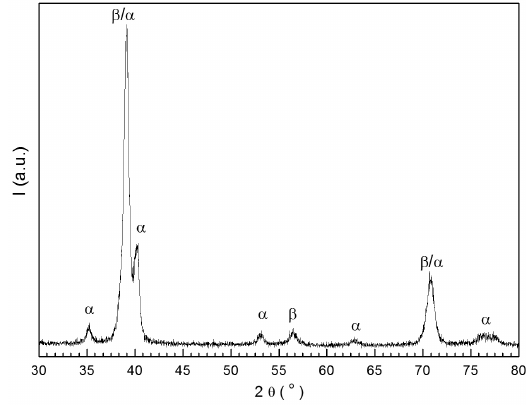
Figure 1. X-ray diffraction pattern of the Ti-12Mo-13Nb alloy hot swaged and aged at 500°C/24 h, showing diffraction peaks from α and β phases.